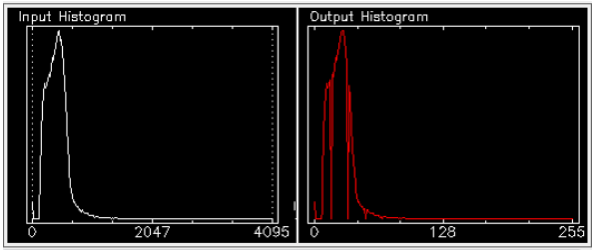
Fig. 4. Histogram stretching for panchromatic channel of image1. Left: 12 bit, right: